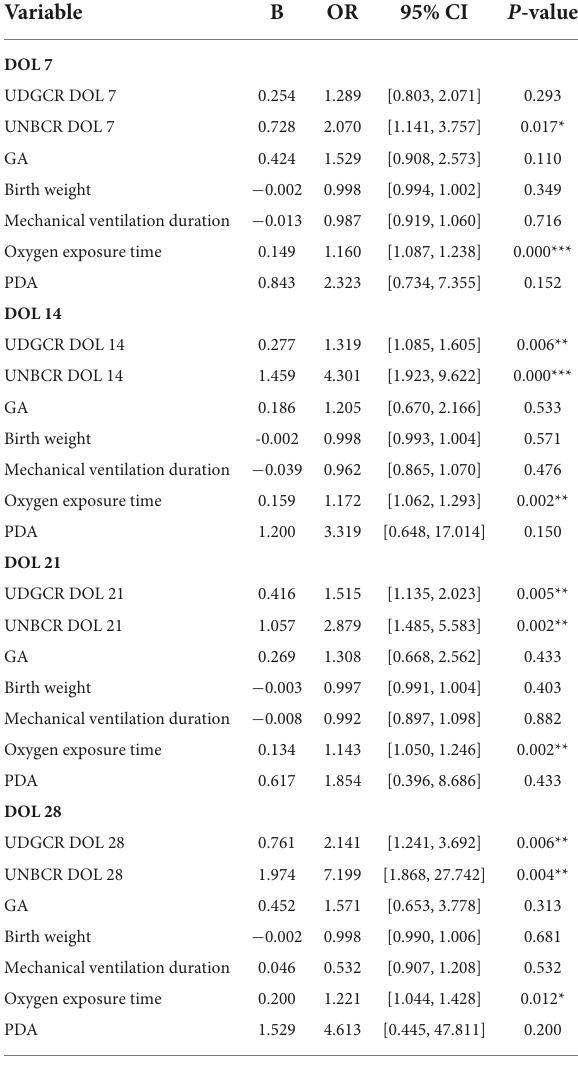
TABLE 3 Predictors and risk factors for BPD (multivariable logistic